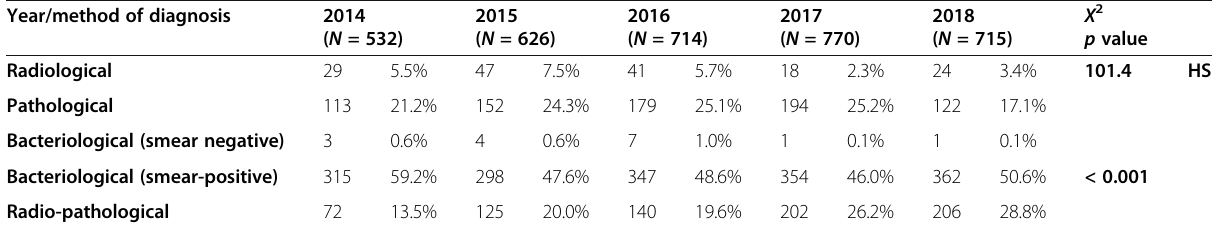
Table 4 Distribution of cases according to the method of diagnosis during the study period